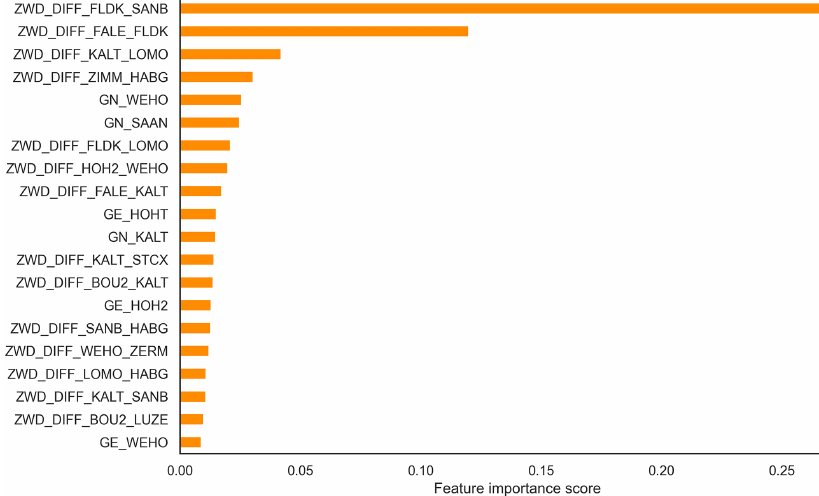
Figure 6. Feature importance score of the 20 strongest predictors for the GB algorithm when using the FS3 setup. Table 9. Performance metrics for FS3 and FS4. Setup Algorithm POD CAR